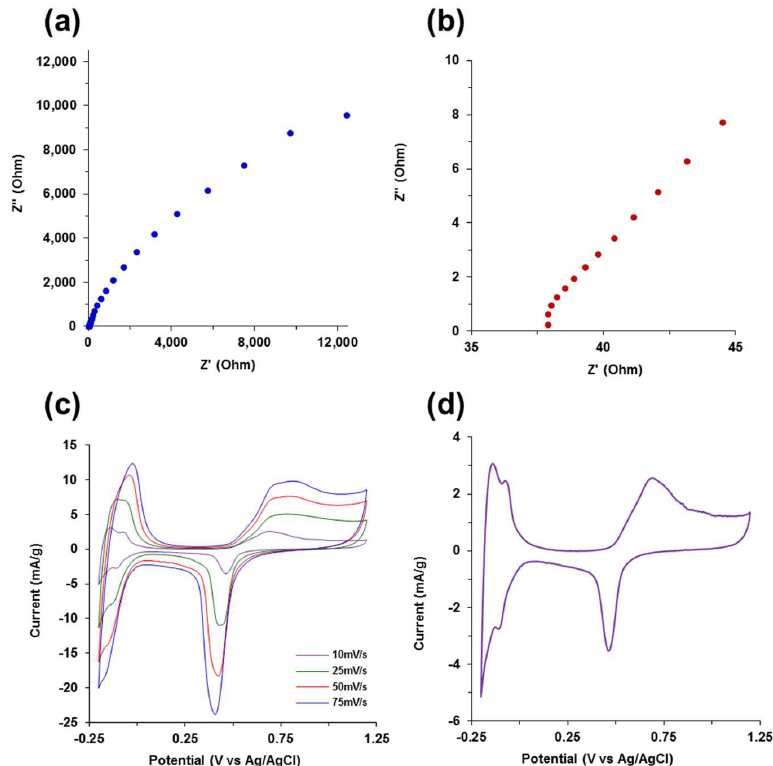
Figure 7. Electrochemical characterization in 0.5 M H 2 SO 4 of CNF-Pd aerogels prepared from 1000